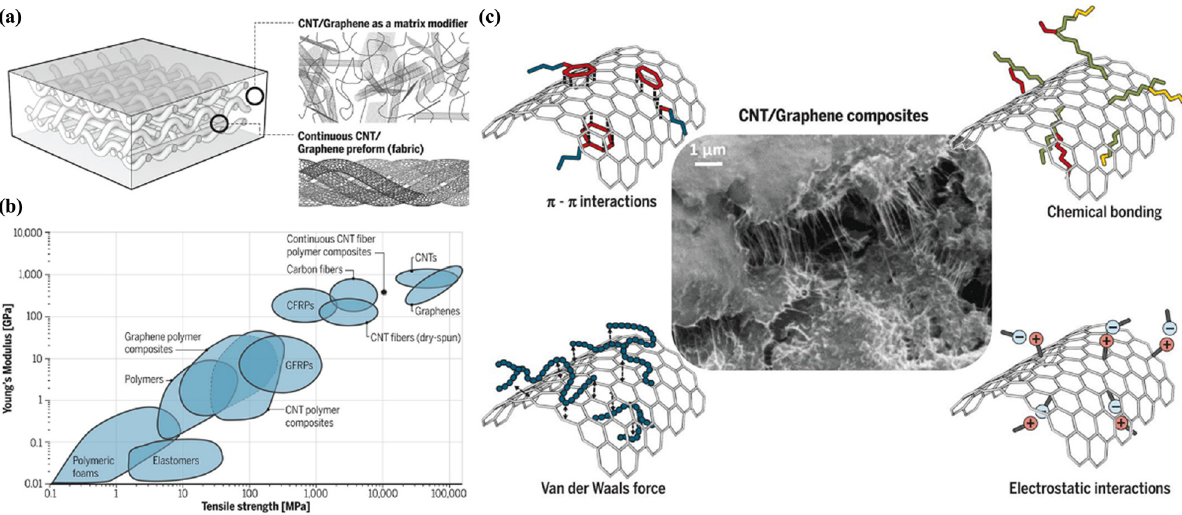
Figure 5: ( a ) Schematic of a composite that consists of the uniform distribution and continuous CNTs or graphene as reinforcements. ( b ) Ashby plot of Young ’ s modulus and tensile strength of composites containing nano - reinforcements [ 158 ] . ( c ) Schematic diagram of four dispersion methods for the interaction between CNTs or GNSs and a polymer matrix [ 158 ] .